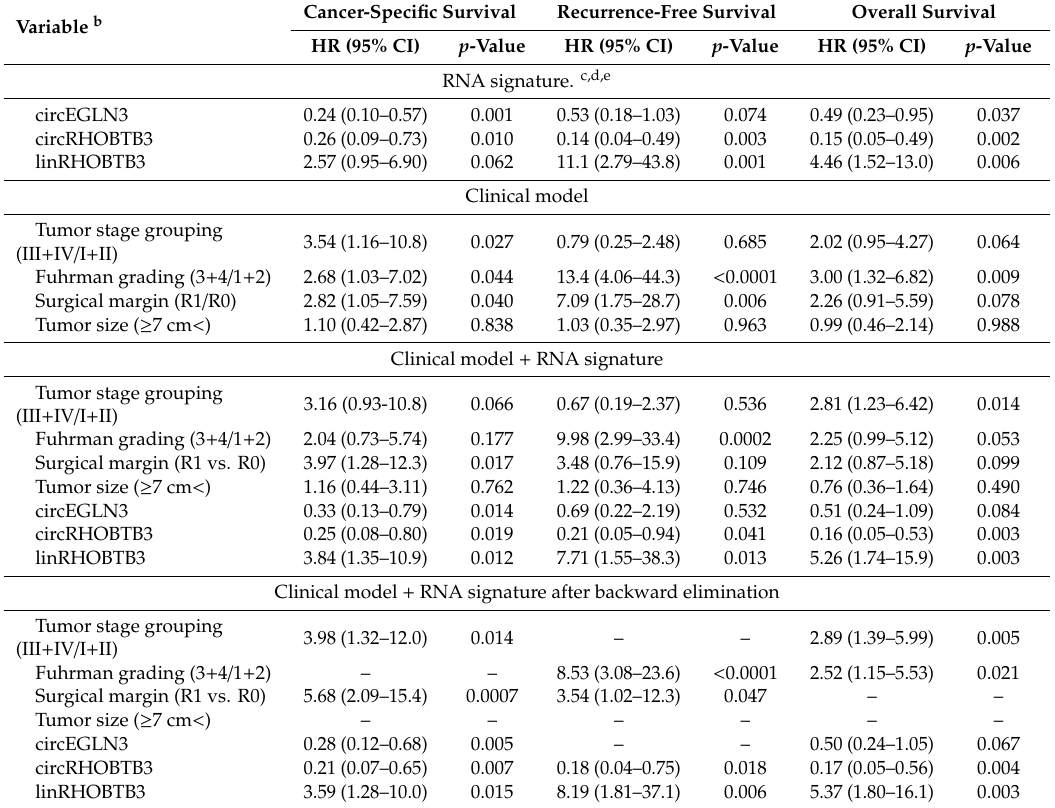
Table 5. Multivariate Cox Proportional Hazard Regression Analyses of Di ff erent Prediction Models for Outcome after ccRCC Nephrectomy a